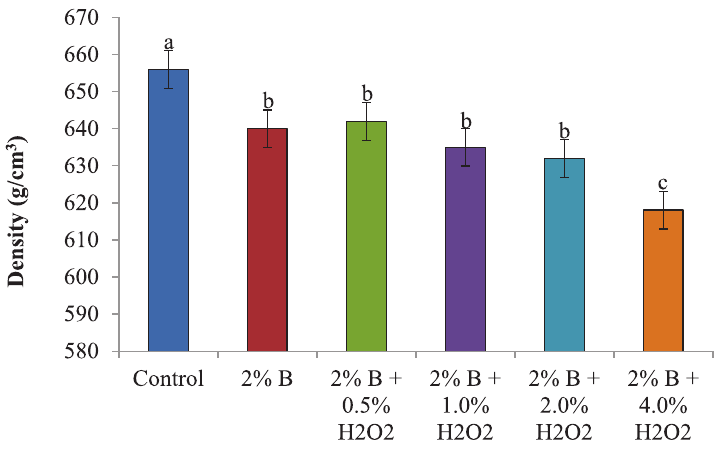
Figure 1 - average density of rubberwood at different treatment level. means within column followed by the same letter are not significantly different at the 5% level of anOva test. Error bar represents the standard